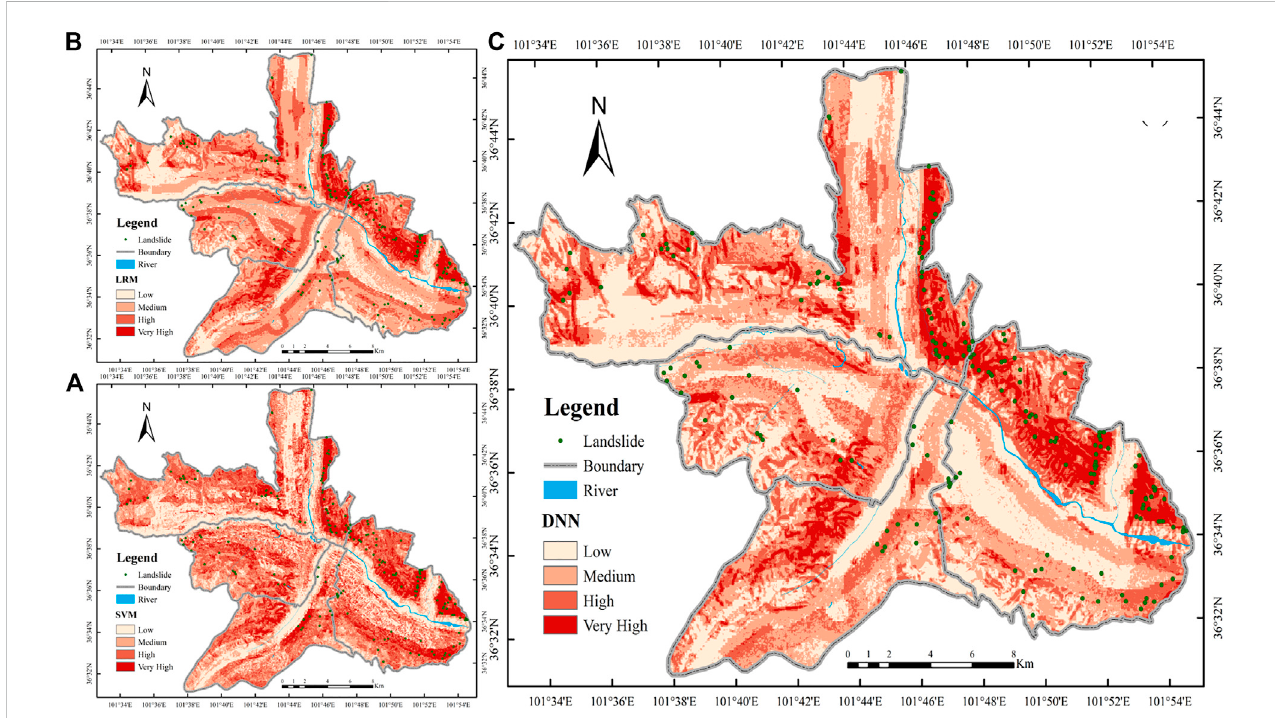
FIGURE 7 The results of the susceptibility evaluation of the coupled model: (A) Support vector machine model susceptibility zoning; (B) the logistic regression model susceptibility zoning; (C) Deep learning susceptibility